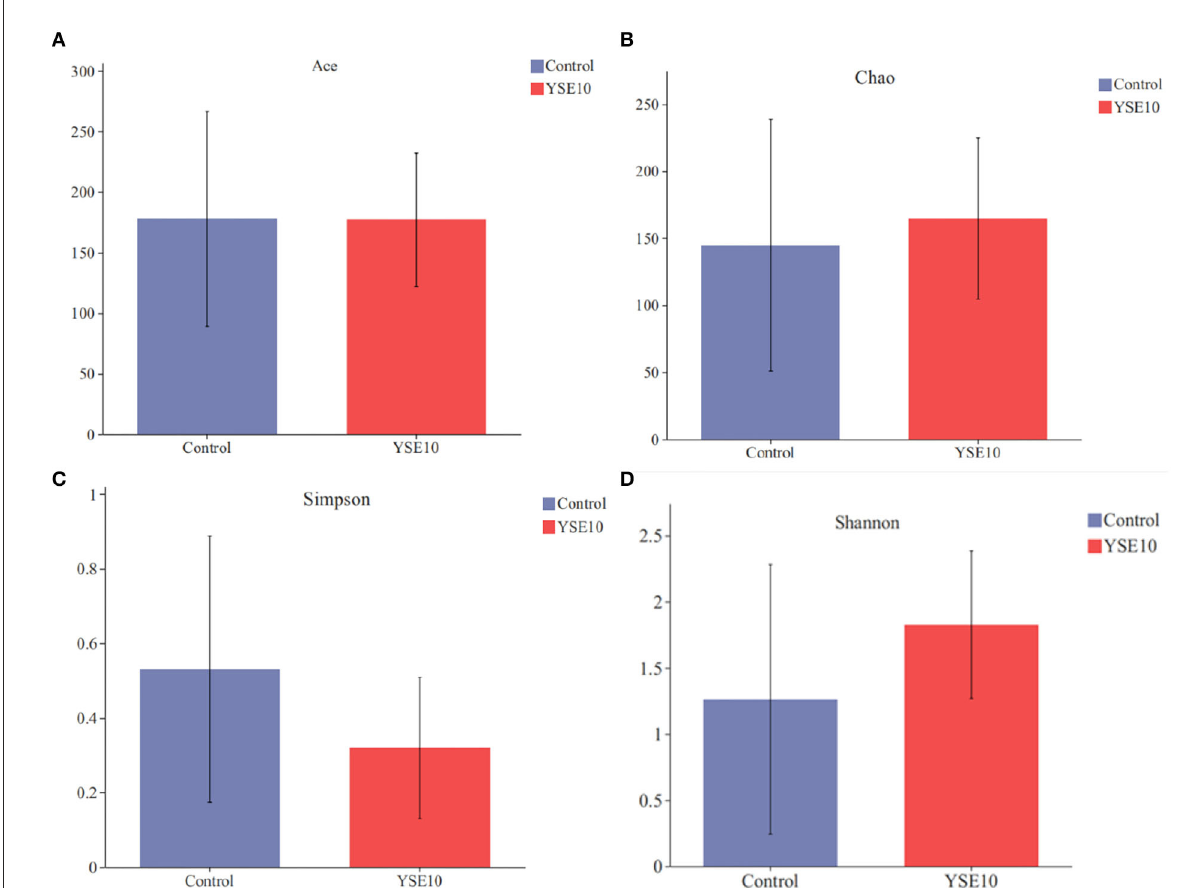
FIGURE3 Alpha diversity of two groups. (A) Ace index; (B) Chao index; (C) Simpson index; (D) Shannan index. Control, 0.9% NaCl solution; YSE10, 10 mg/mL